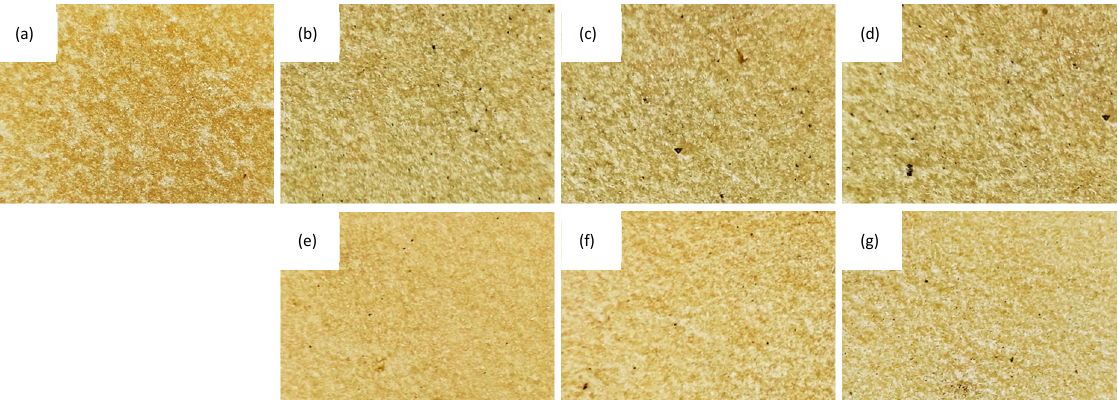
Figure 5. Optical images of the external surface of ( a ) polyurethane (PUR)-0, ( b ) PUR-SO-1, ( c ) PUR-SO-2, ( d ) PUR-SO-5, ( e ) PUR-SO/MTM-1, ( f ) PUR-SO/MMT-2, ( g ) PUR-SO/MMT-5.